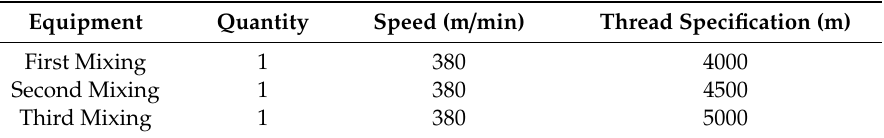
Table 6. 60% / 40% product process parameters.